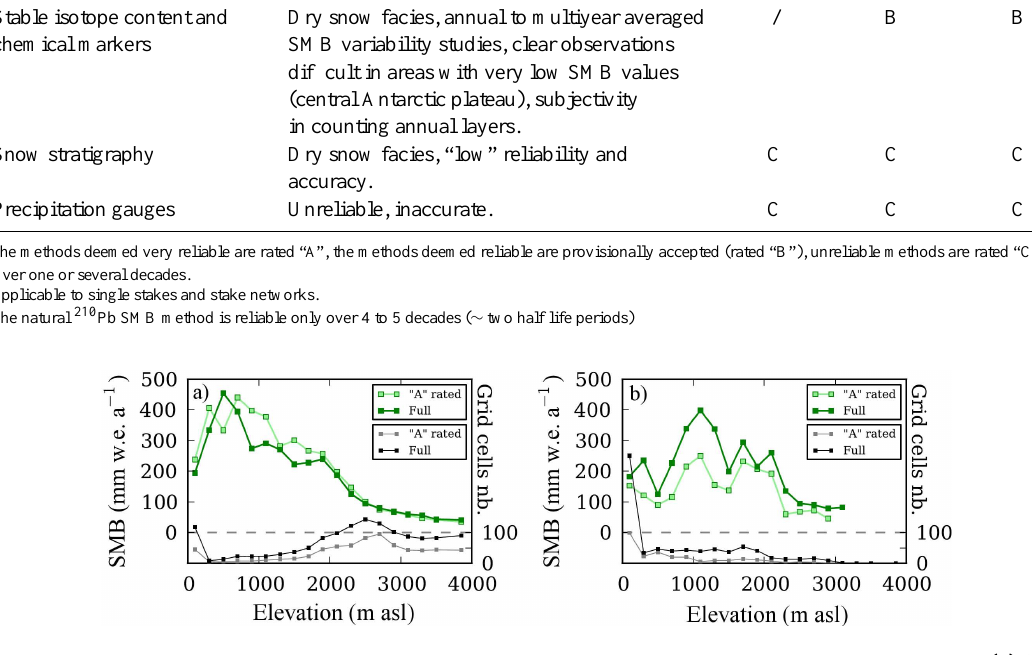
Fig. 2. Mean SMB computed using field data measured within each 200m elevation range on the grounded ice sheet, (a) for the eastern Antarctic sector (longitude between 0 ◦ E and 180 ◦ E), and (b) western Antarctic sector (longitude between 0 ◦ W and 180 ◦ W). We first computed the average SMB for each 15 × 15km 2 grid cell (values from points located in the same grid cell are averaged), and then the mean SMB every 200m in elevation assuming that each grid cell had the same weight. Dark green squares are mean SMB computed with the full database, and light green squares are mean SMB computed with “A” rated data only. Gray and black dots are the number of grid cells within each elevation range for the “A” rated data and the complete (“full” SAMBA-LGGE) database,